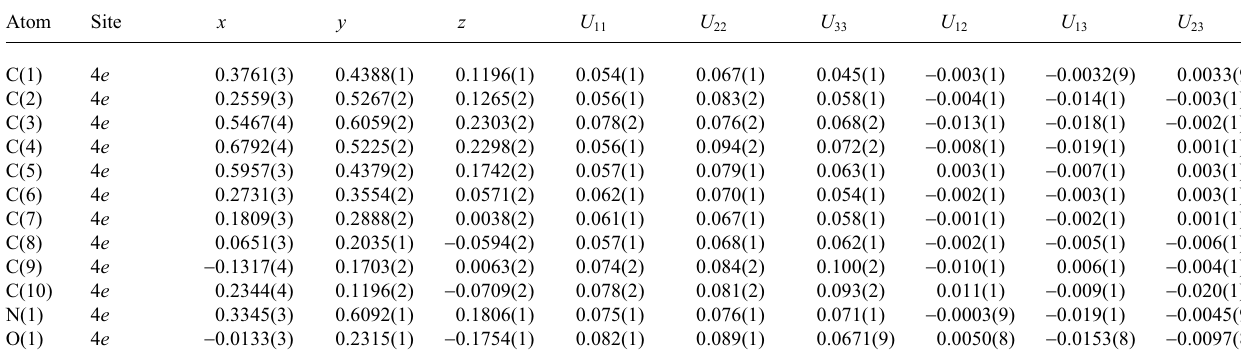
Table 3. Atomic coordinates and displacement parameters (in Å 2 )